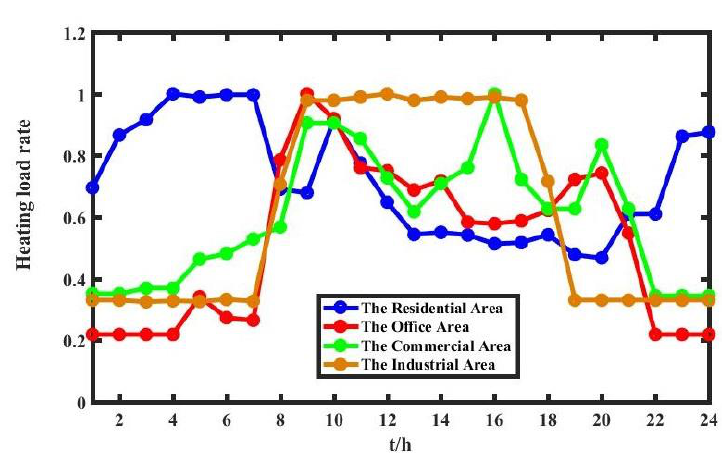
Figure 1. Typical heating load rate curves of multiple functional areas.